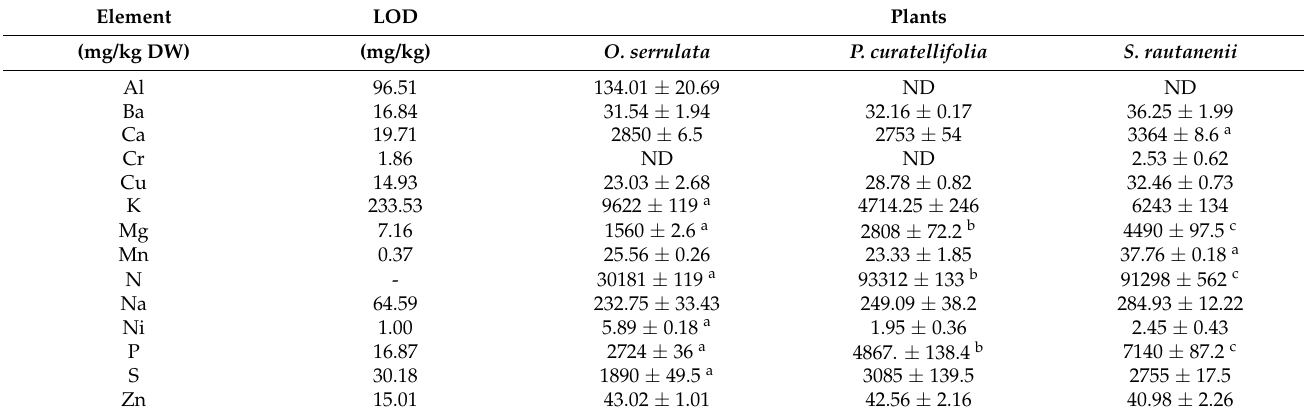
Table 5. Macro- and microelements in the cakes obtained after Soxhlet oil extraction.